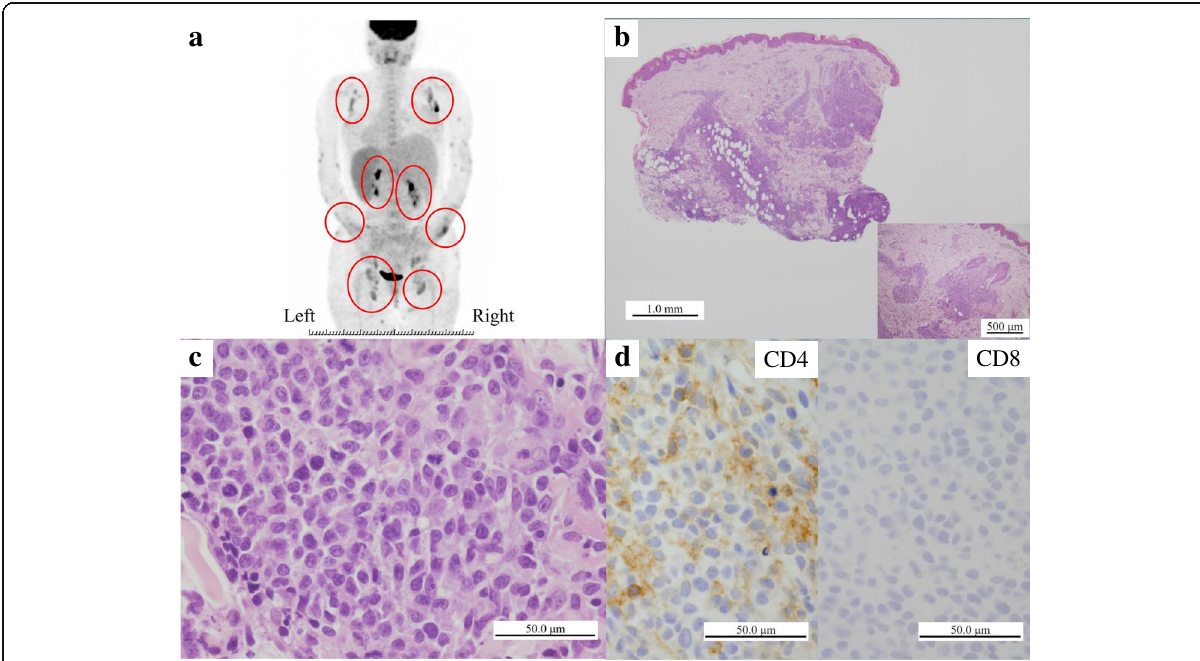
Fig. 1 18 F-FDG-PET, and microscopic and immunohistochemical findings of the skin biopsy specimen. ( a ) 18 F-FDG accumulated in the axilla, intra-abdominal lymph nodes, inguinal region, and skin of bilateral upper extremities on a whole body 18 F-FDG-PET scan performed one month after the onset. ( b ) A low-power view of a skin biopsy specimen of the right forearm taken 10 days after the onset of symptoms revealed that lymphoid cells had infiltrated around the vessels and appendages in the middle to deep dermis and subcutis. Bar = 1 mm (H&E staining) (original magnification: × 12.5). Bar = 500 μ m (H&E staining) (original magnification: × 40) (inset). ( c ) A high-power view of the specimen revealed mitosis and anisonucleosis of these cells. Bar = 50 μ m (H&E staining) (original magnification: × 400). ( d ) Immunohistochemistry revealed that these cells were positive for CD4 but negative for CD8. Bar = 50 μ m (original magnification: ×